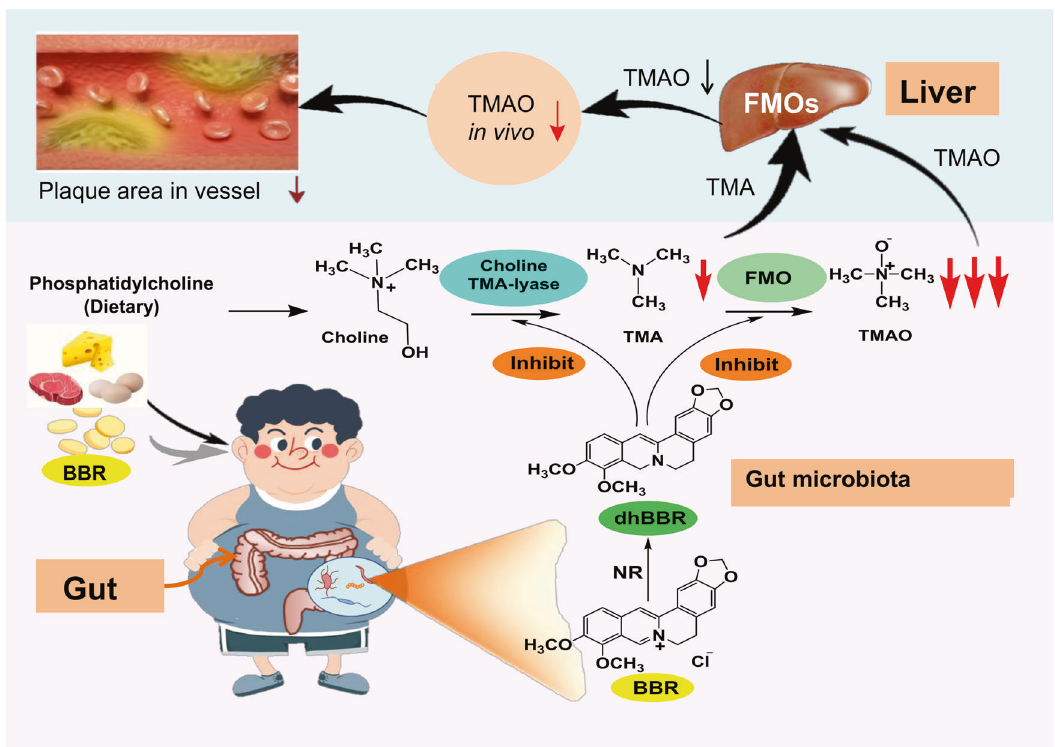
Fig. 7 Berberine (BBR) treats atherosclerosis through its vitamin-like effect down-regulating TMAO production in the gut